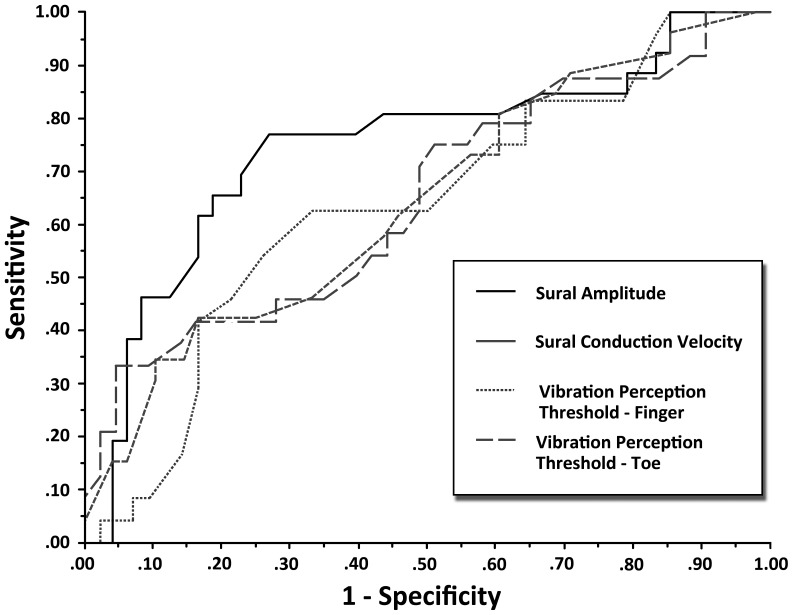
Shows the ROC curves for large fiber function tests of sural nerve amplitude and conduction velocity and vibration perception thresholds at index finger and first toe.The curve for sural nerve amplitude lies closest to the upper y-axis and has the largest AUC at 0.75.